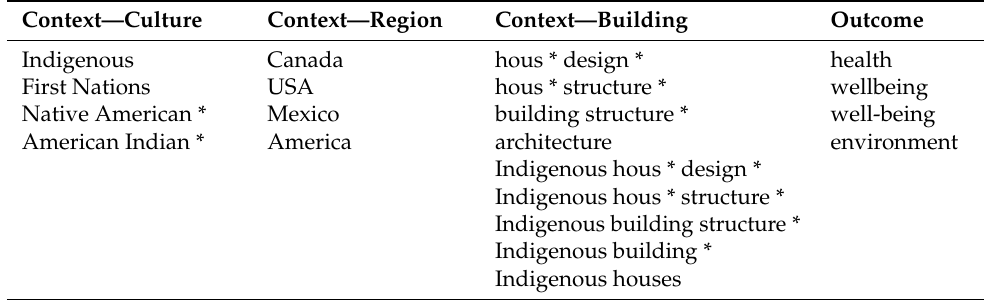
Table 1. Search Terms.